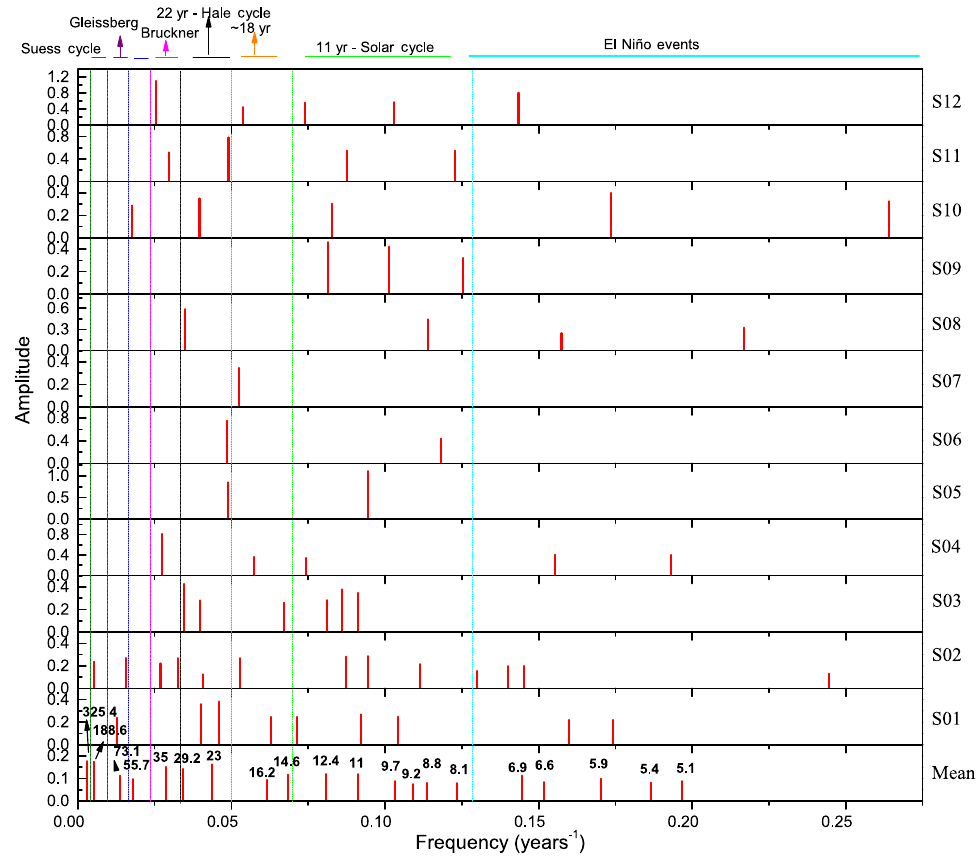
Figure 3. Amplitude spectra for each tree-ring thickness sample at a confidence of 95% from S01 to S12 (top 12 panels) and the average of them (bottom